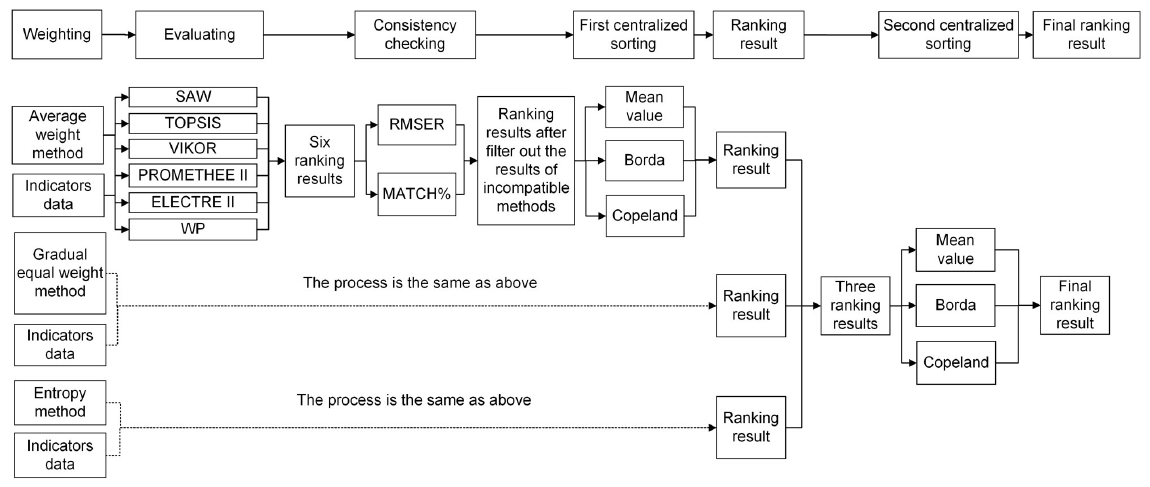
Fig. 4 . Resilience evaluation method.